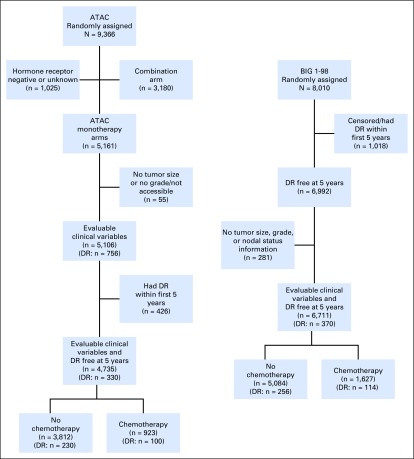
CONSORT diagram according to trial. ATAC, Arimidex, Tamoxifen, Alone or Combination; BIG, Breast International Group; DR, distant recurrence.